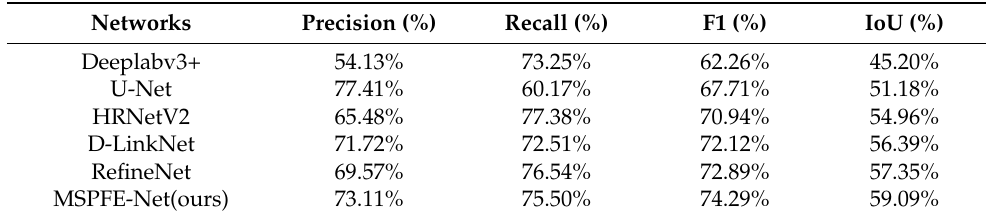
Table 1. Numerical results of different